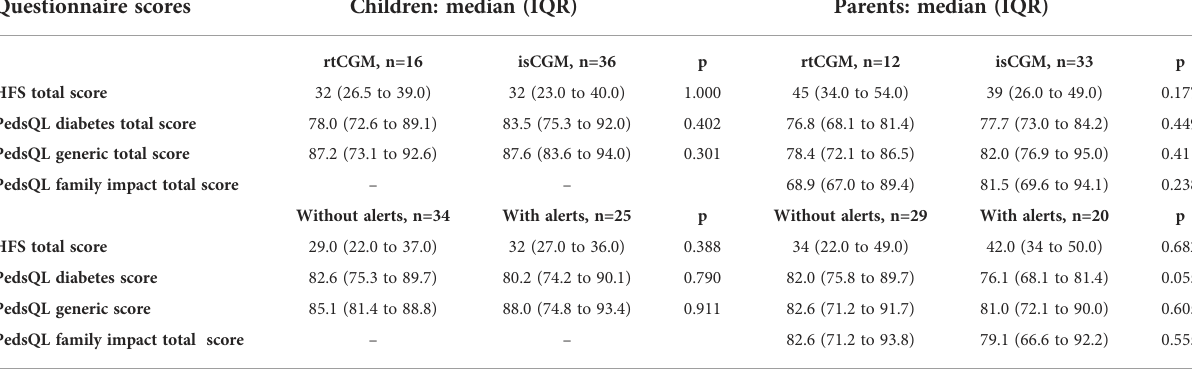
TABLE 4 Questionnaire scores of real time continuous glucose monitoring (rtCGM) users vs. intermittently scanned CGM users (isCGM) and glucose monitoring devices without (self-monitored blood glucose (SMBG) and isCGM without alerts) vs. with (rtCGM and isCGM with alerts) in children and parents: data are expressed as median